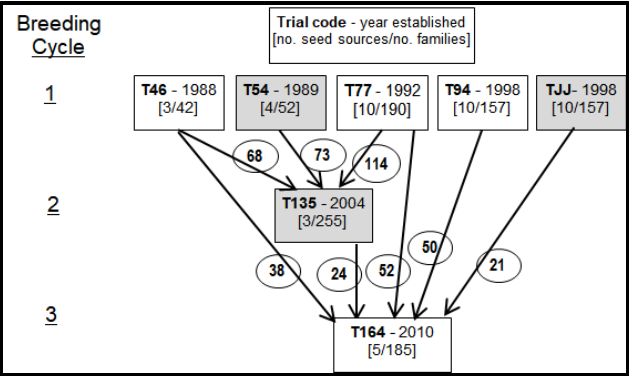
Figure 1. Development of three successive cycles of Eucalyptus urophylla S.T.Blake breeding in China. Trials shaded in grey were not sampled for this study; circled numbers indicate number of families contributing to the succeeding trial indicated by the associated arrow.